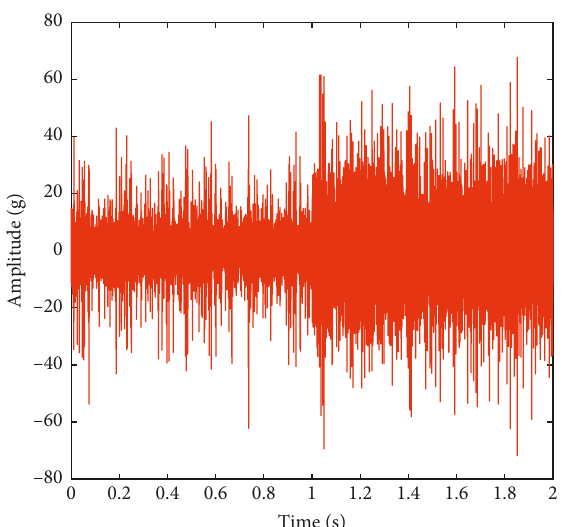
Figure 1: Normal state and 2/3 broken tooth state vibration signal